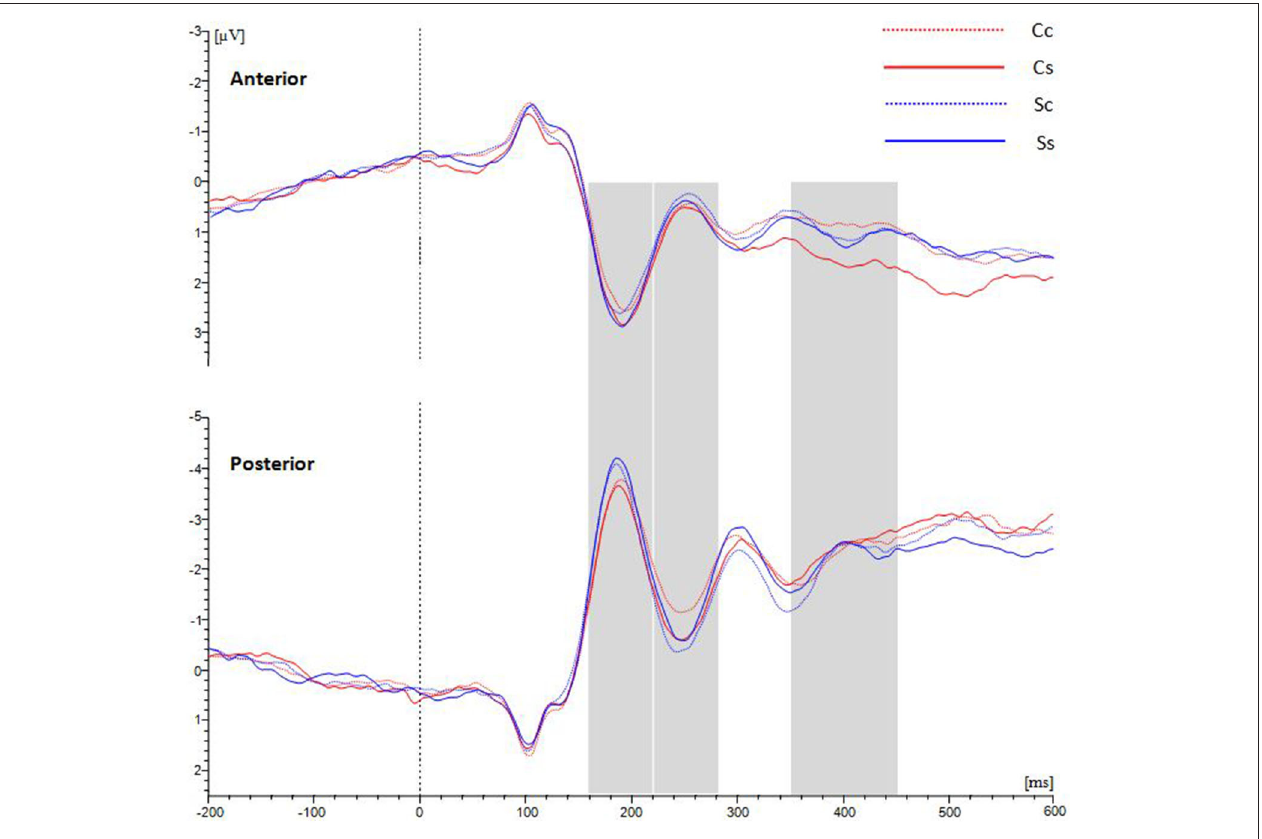
more positive component than circle stimuli (red lines). Between 350–450 ms at the anterior ROI, spiral perception (continuous lines) elicited a more positive component than circle perception (dotted